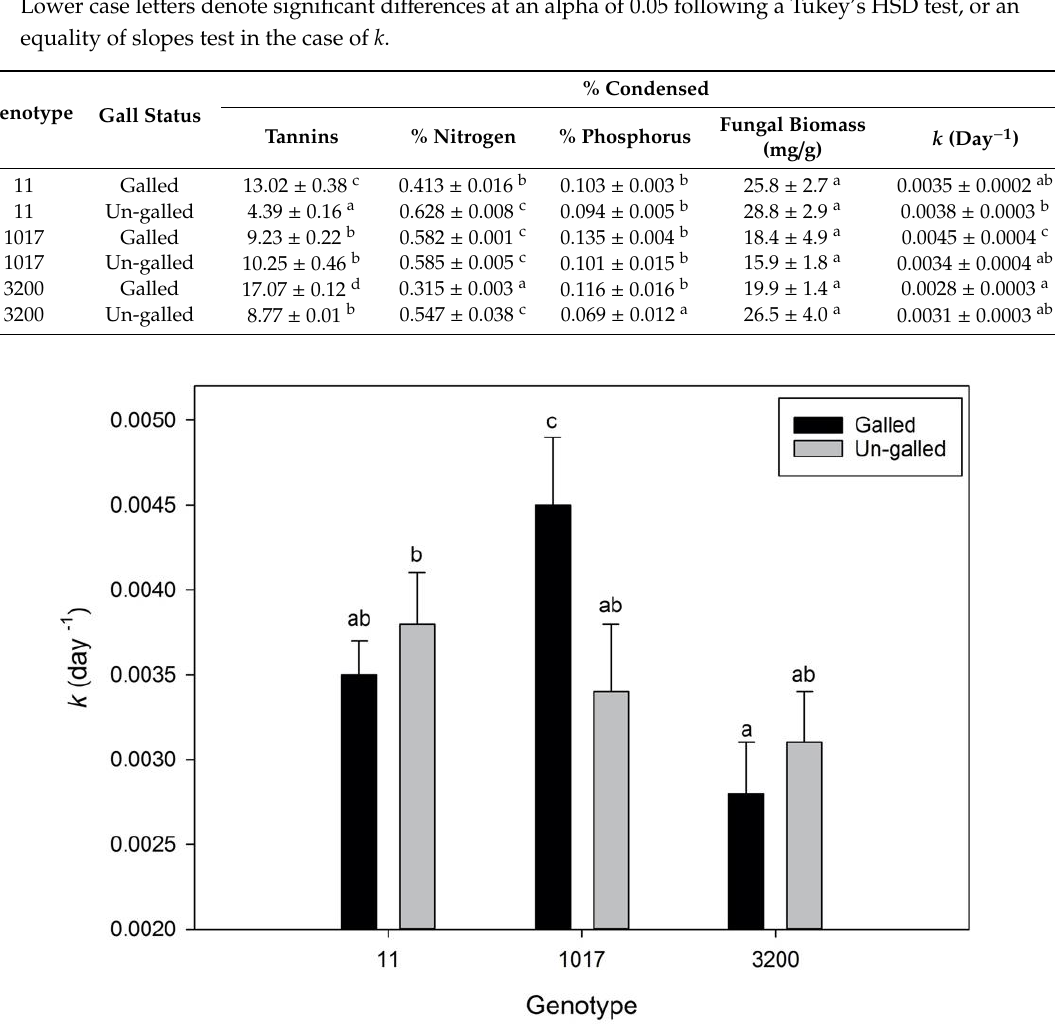
Figure 2. Decomposition rate constants ( k day − 1 ) for three backcross hybrid cottonwood genotypes comparing galled to un-galled leaf litter. Values represent mean slopes ± 1 S.E. and lower case letters denote significantly different slopes based on contrasts at a Hommel’s corrected alpha level of 0.05. Table 4. Three-way ANOVA results for litter chemistry throughout the decomposition process. Values represent overall F (df1,df2) -ratios and p -values as well as effect test p -values for each main effect